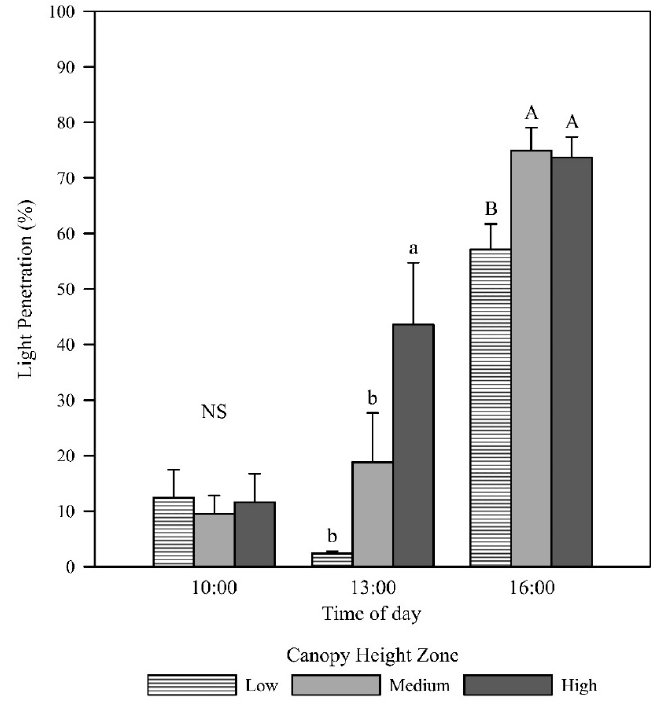
Figure 2. Mean light penetration at low, middle, and high canopy zones taken in the morning (10:00 h AEST; p = 0.899), at solar noon (13:00 AEST; p = 0.001), and in the afternoon (16:00 AEST; p = 0.014). Error bars represent the standard errors of the means. Letters represent mean separation of data at each time point by Fisher’s unprotected LSD ( α = 0.05).